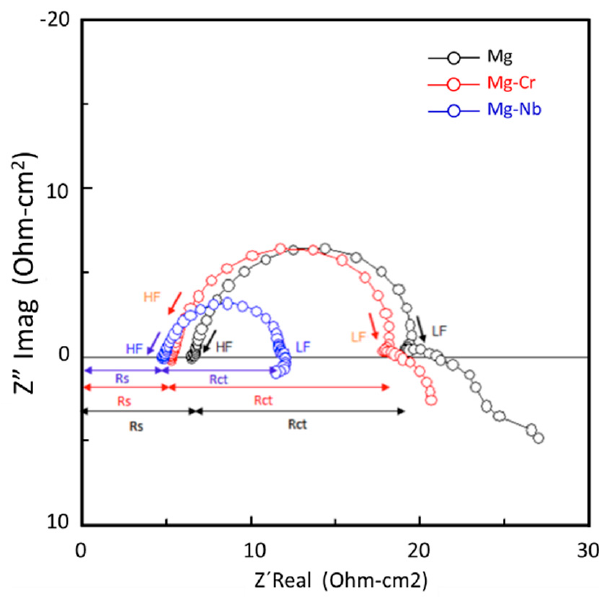
Figure 7. Nyquist diagrams of the anode-electrolyte systems immediately after being introduced into seawater.